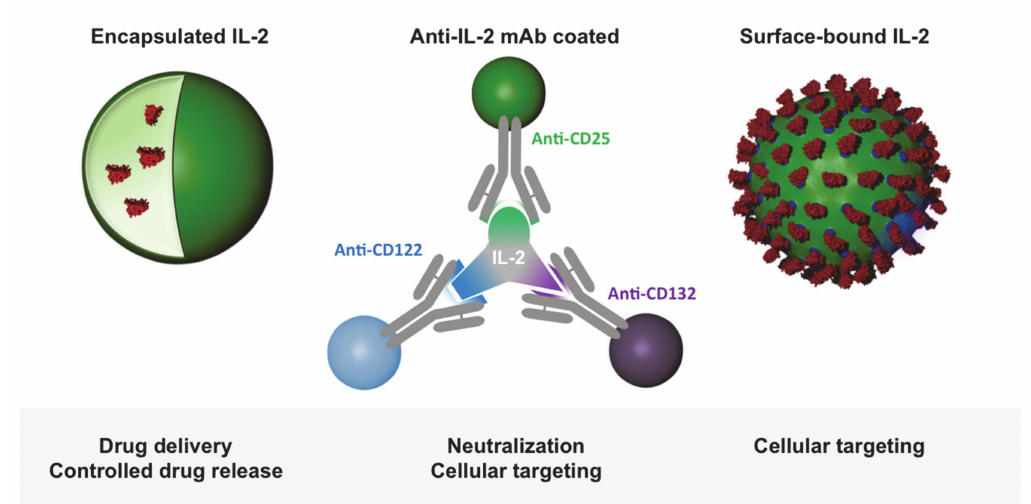
Figure 5. IL-2-functionalized nanocapsules for T cell targeting. Hydroxyethyl-starch (HES) nanocapsules were functionalized with dibenzylcyclooctyne (DBCO)-PEG 5 -NHS ester binding to NH 2 groups on the carriers’ surface to introduce an active alkyne group (HES-D). IL-2 was azide-functionalized at its N terminus and coupled onto the DBCO-HES nanocapsules via copper-free click reaction. These capsules can be taken up by human and murine T cells. Di ff erent concentrations of IL-2 on the nanocapsule surface resulted in increased or reduced targeting and proliferation of Treg or e ff ector T cells, respectively, (modified from Frick et al.